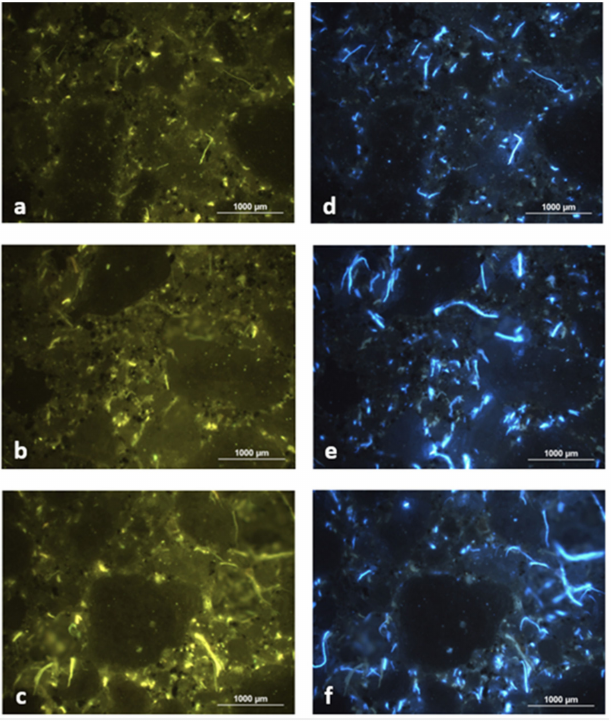
Figure 14. Micrographs of the texture of 28-day fiber-cement mortars samples A3 ( a , d ), B3 ( b , e ), and C3 ( c , f ) for C/WPF with a ratio of 200:1 under UV light using WB (left) and WU filter